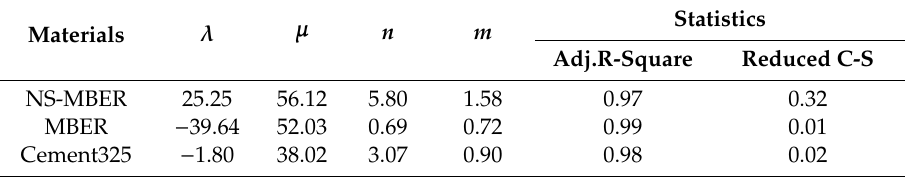
Table 5. Calculation results and fitting degree of model